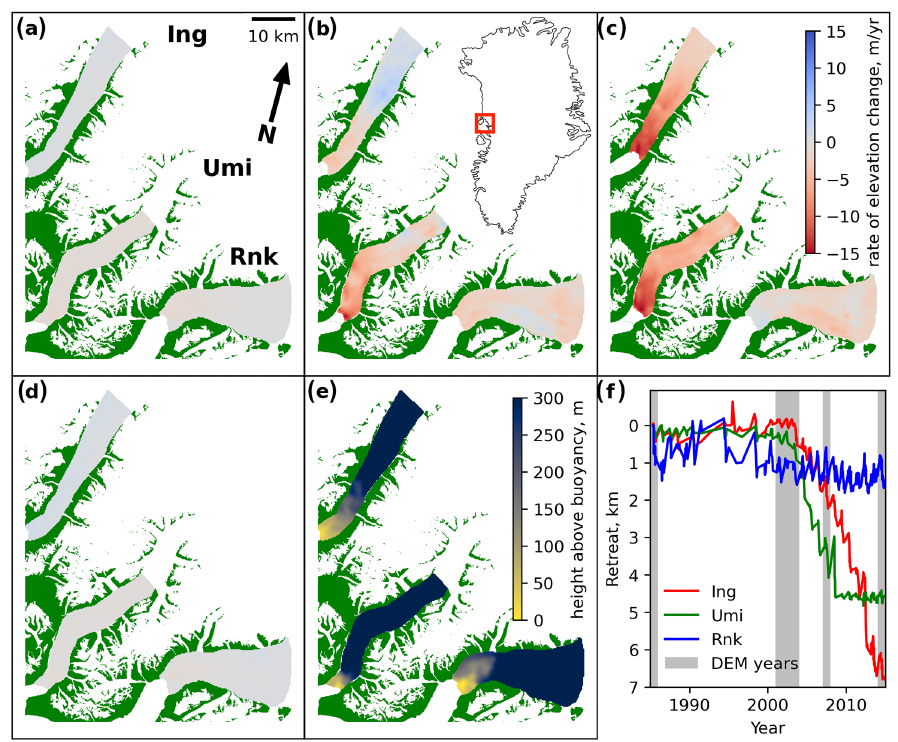
Figure 1. Rate of total elevation change for Inngia Isbræ (Ing), Umiammakku Isbræ (Umi), and Rink Isbræ (Rnk) from (a) 1985 to ∼ 2002 (Inngia – 2003, Umiammakku – 2002, Rink – 2001) (b) ∼ 2002 to ∼ 2007, and (c) ∼ 2007 to ∼ 2015. (d) Dynamic thinning (total thinning minus thinning from surface mass balance prior to glacier retreat) from 1985 to ∼ 2002. (e) Glacier height above buoyancy assuming an open connection to sea level, an ice overburden pressure upper bound, in 1985. In green is the land around the glaciers. All glaciers shown flow from the interior of Greenland on the right-hand side of the figures to the ocean on the left where they terminate. (f) Glacier retreat histories since 1985 (Catania et al., 2018), along with dates of DEMs